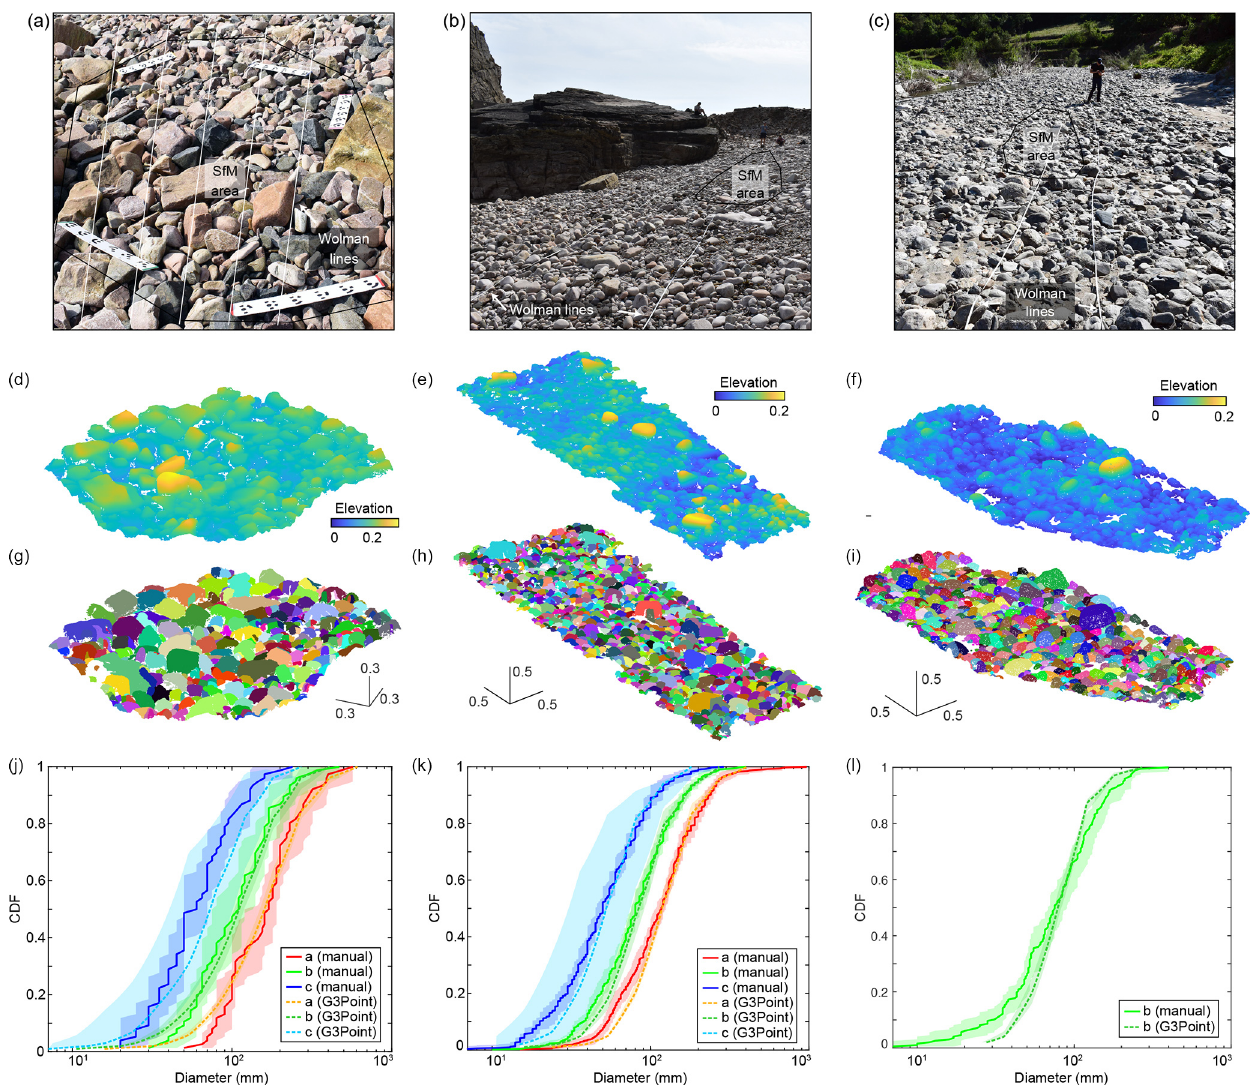
Figure 6. Field pictures (a–c) , initial point clouds colored coded in elevation and segmented point clouds (d–i) , and grain-size distributions (j–l) from (a) Site 1 and (b) Site 2 of the Pointe du Château Renard and (c) the Hérault River. Distributions of the a (red), b (green) and c (blue) axis result from Wolman counts (dark colors) and G3Point (light color dash lines). Shaded envelopes correspond to uncertainties defined by bootstrap approach for Wolman counts and by the envelope defined by the two fitting methods for G3Point (see text for details). Locations of the Wolman lines (white) and SfM covers (black polygons) are indicated in the pictures. Table 1. Statistics of the grain-size distributions for the three sites surveyed by SfM. The six coefficients ( k , CF, α , β , ϕ flat , A thres ) are the parameters required for G3Point (see text for